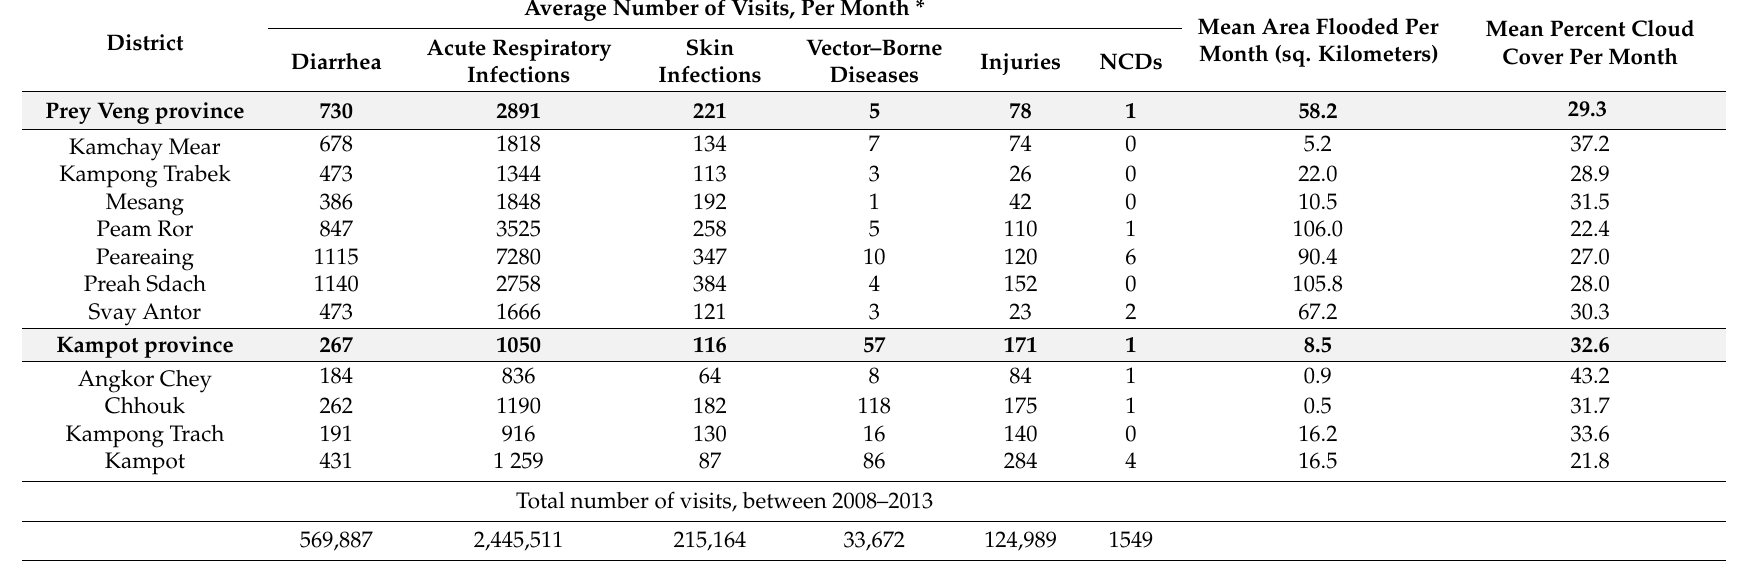
Table 2. Summary of health and flood data between 2008 and 2013 by province and district. Average Number of Visits, Per Month *